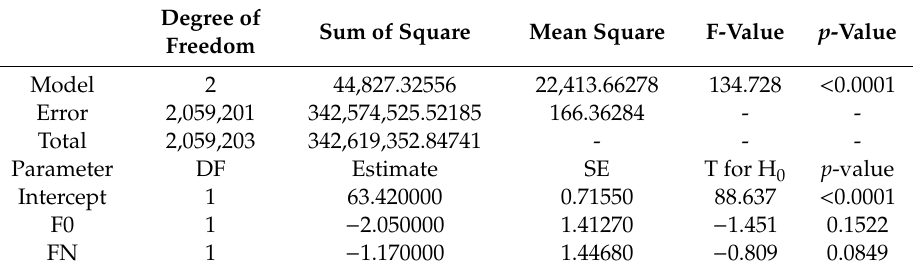
Table 12. Covariance analysis test for H2.